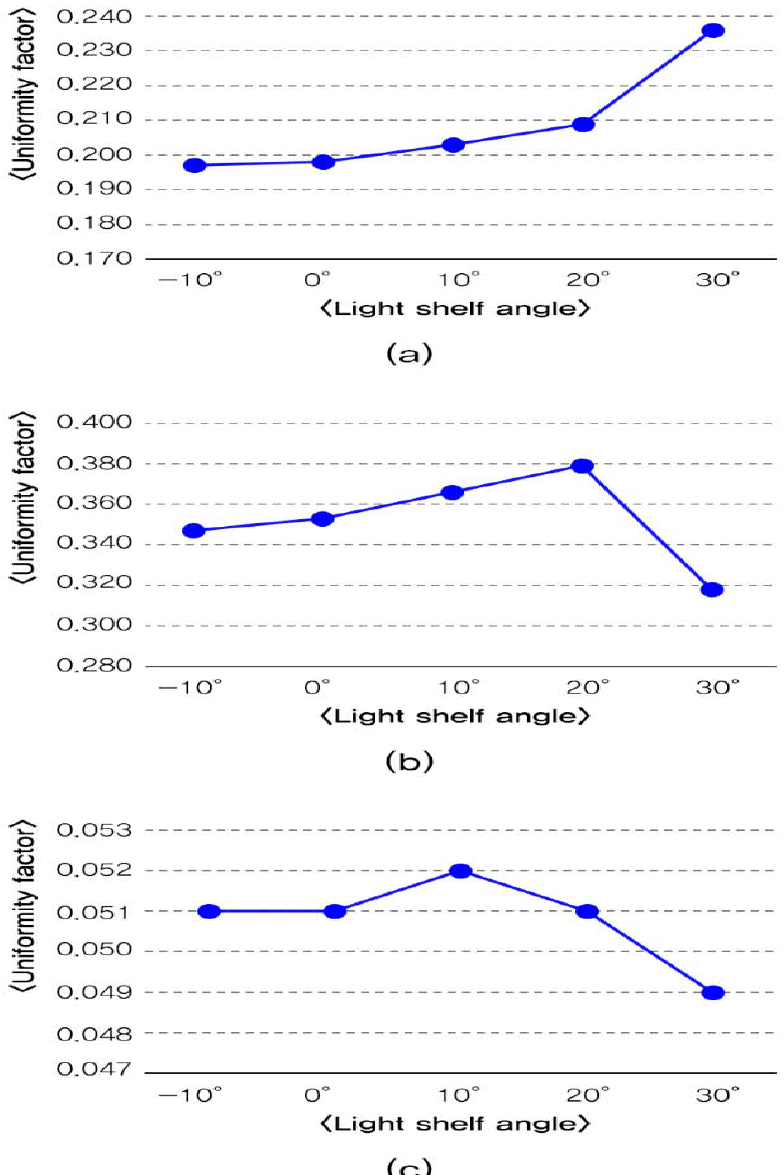
Figure 8. Analysis of uniformity per light shelf angle: ( a ) uniformity per light shelf angle in summer; ( b ) uniformity per light shelf angle in middle season; ( c ) uniformity per light shelf angle in winter.